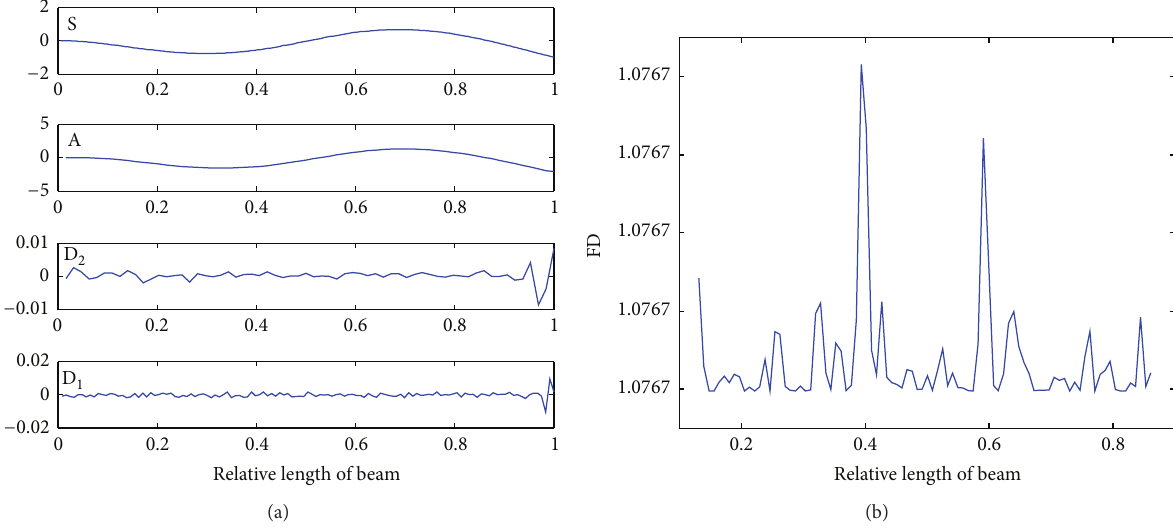
Figure 7: Crack location identification results in 80 dB noise level for the third mode shape. (a) Noise contaminated the first mode shape S N and its wavelet decomposition at level 2. (b) FD of the detailed signal D 1 .